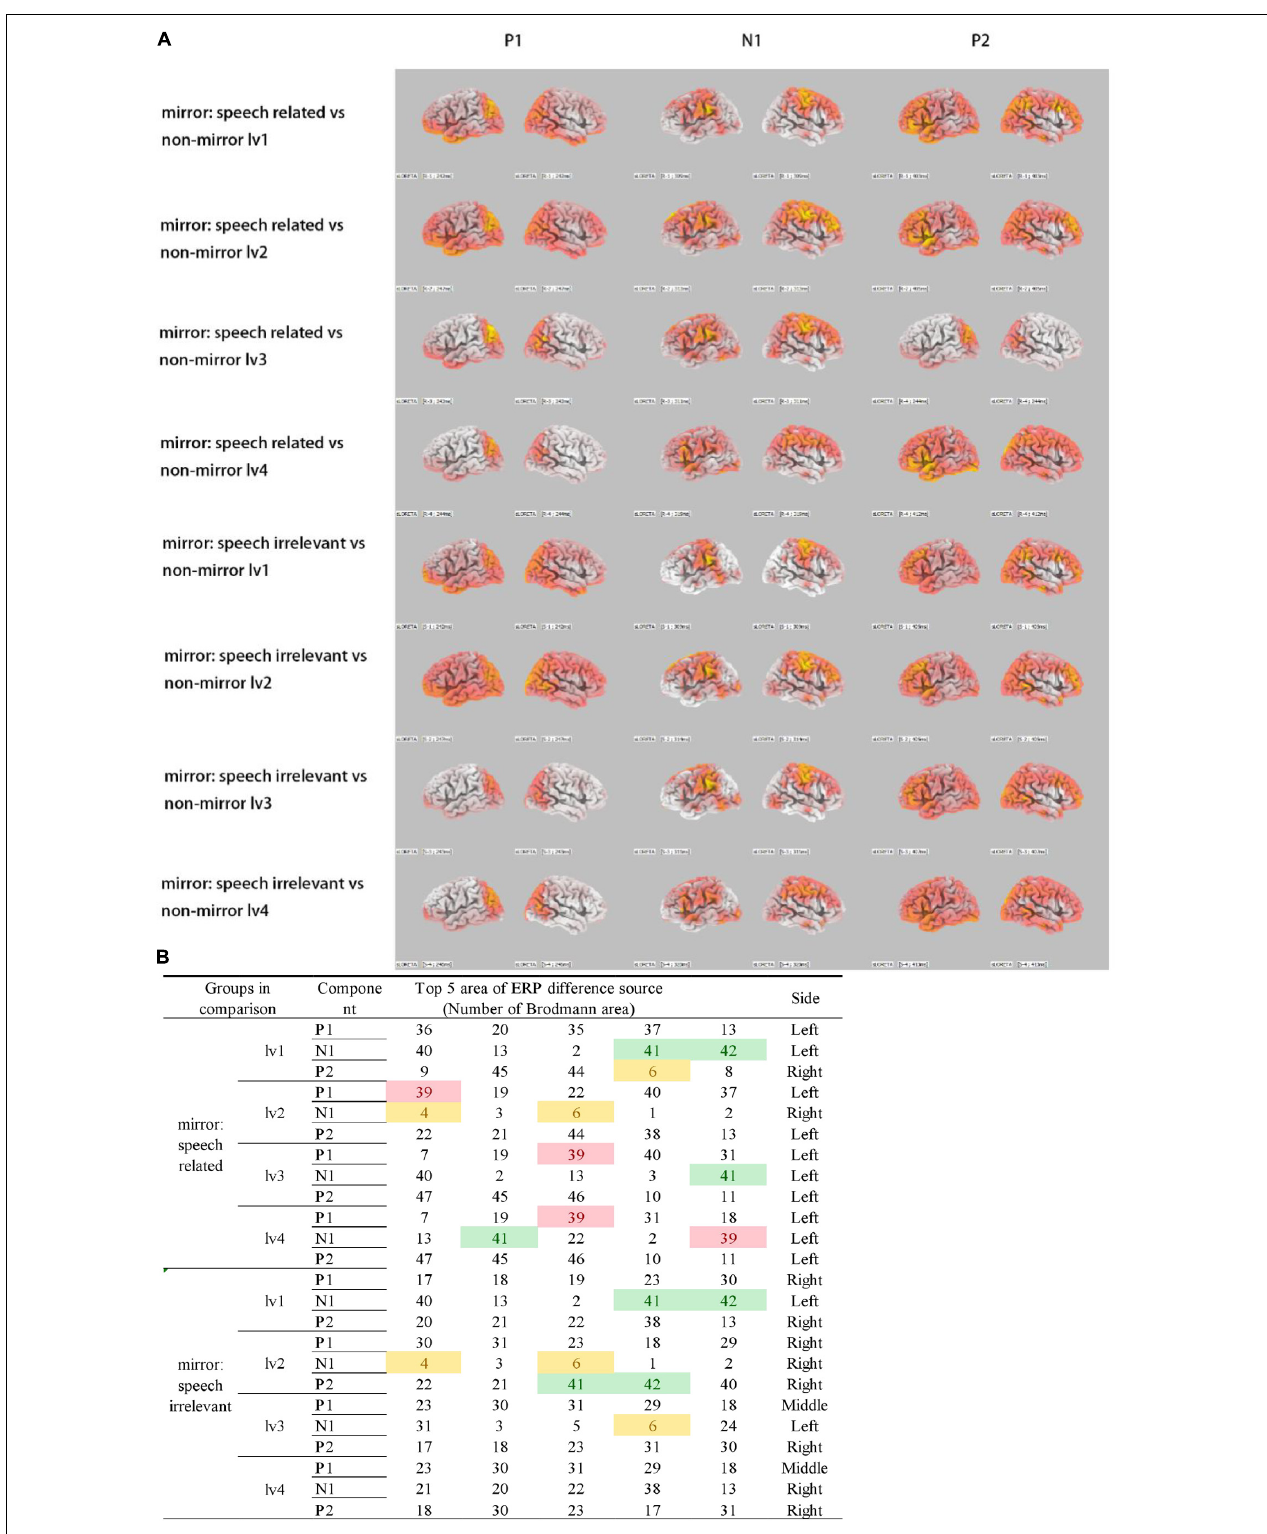
FIGURE 2 | Source location of ERP differences. (A) sLORETA for ERP differences between groups. Colorful regions indicate the source of ERP differences. (B) Red: BA39 (left), which is the visual speech cortex. Green: BA41 and BA42, which make up the primary auditory cortex. Yellow: BA4 and BA6, which make up the precentral gyrus. Only speech-related stimuli activated BA39 differently, compared with non-mirror stimuli.